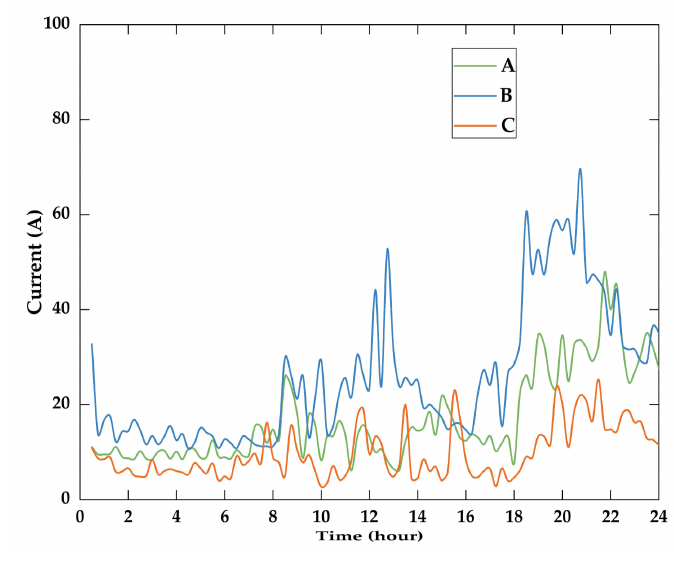
Figure 9. Load currents.